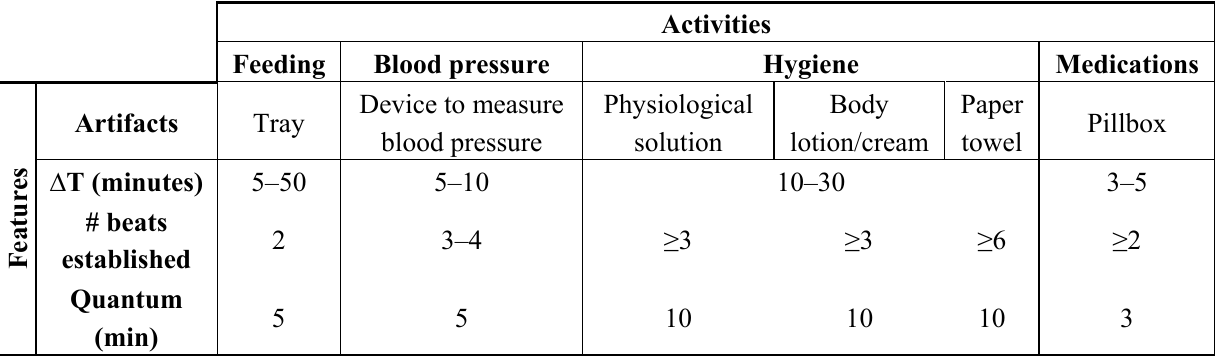
Table 1. Criteria by artifact with its related